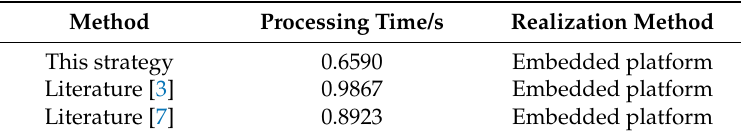
Table 7. Comparison of Recognition performance of each cognitive strategy.